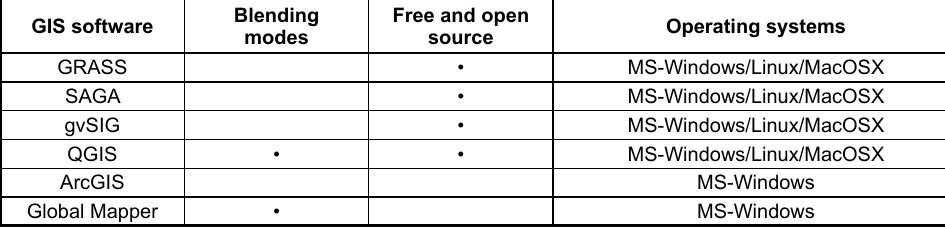
Table 1. Comparison of popular GIS software by availability of blending modes GIS